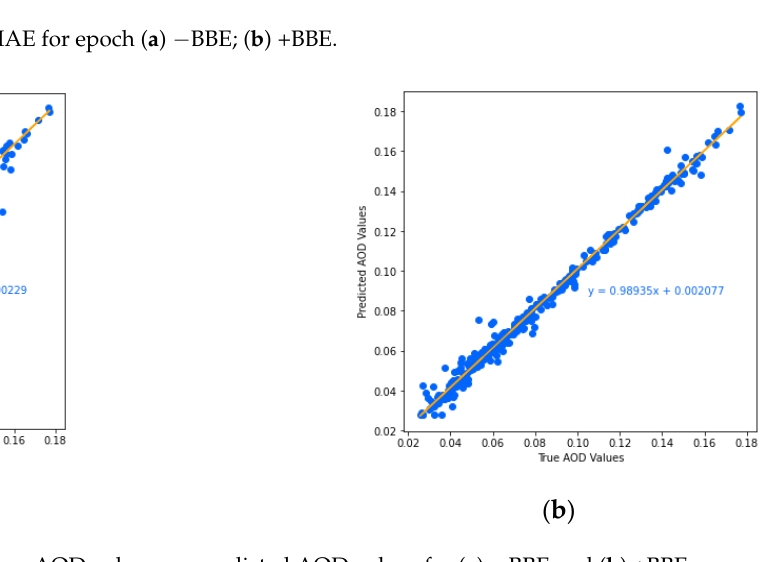
Figure 4. True AOD values vs. predicted AOD values for ( a ) − BBE and ( b ) +BBE. 233 When comparing the average of the true and predicted AODs from 2007 to 2015, our results are consistent with other studies that indicate that BBEs cause an increase in